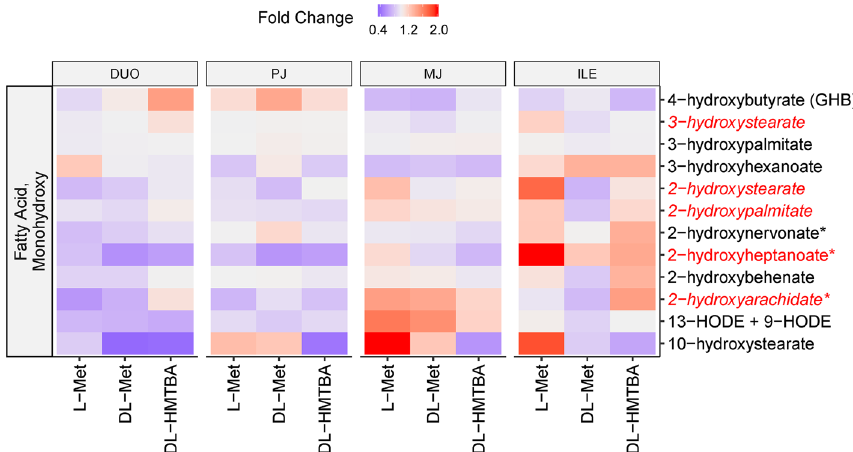
Figure 3. Heat map of the monohydroxy fatty acids pathway, showing the distribution of all measured pathway- related metabolites along duodenum (DUO), proximal jejunum (PJ), middle jejunum (MJ) and ileum (ILE) in pigs pre-fed with L-Met, DL-Met or DL-HMBTA. Blue color indicates lower abundance whereas red color indicates higher abundance of metabolites. Red writing of individual metabolites indicates a treatment effect or, if combined with italics, a region × treatment interaction ( P < 0.10).